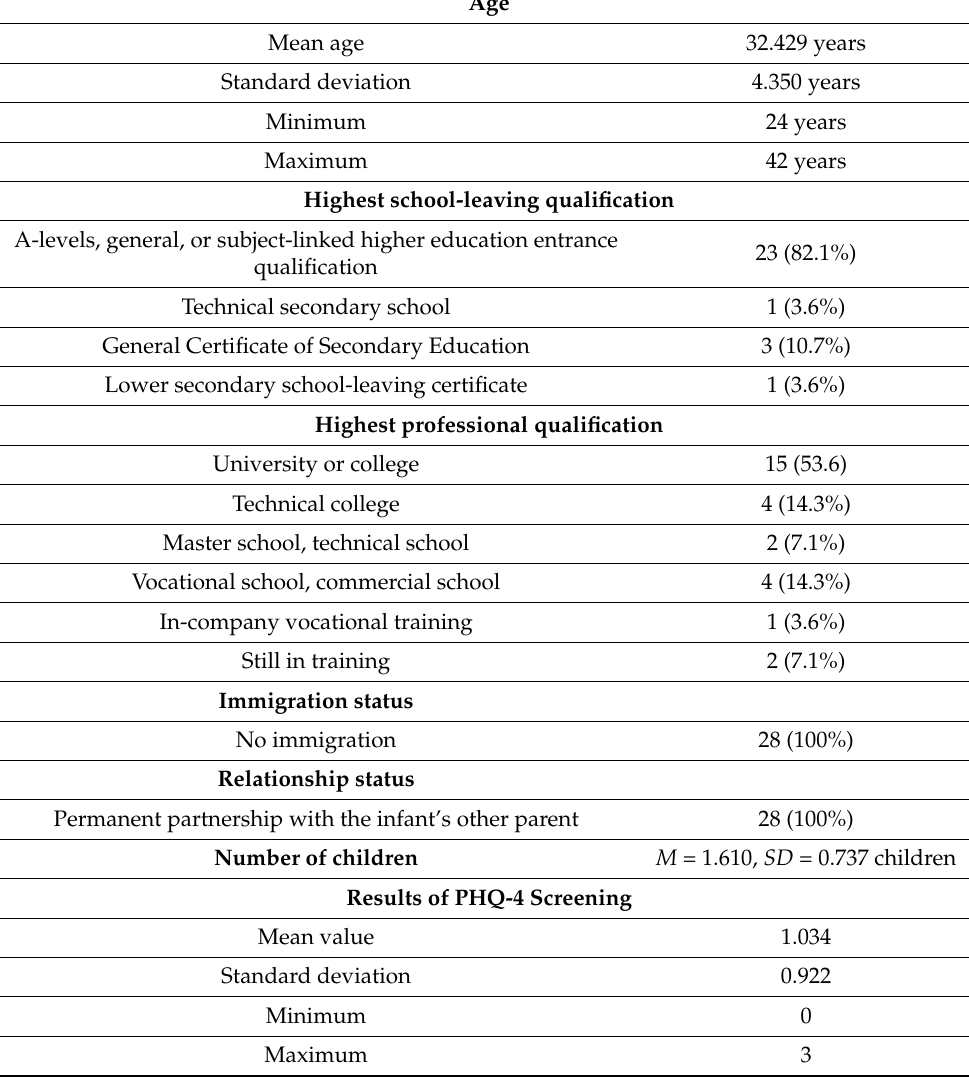
Table A1. Sociodemographic characteristics of participating mothers.